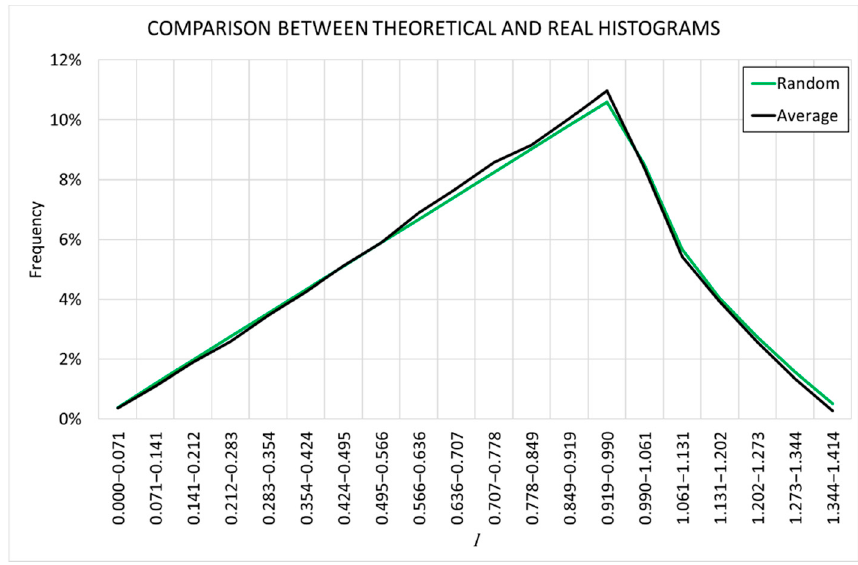
Figure 9. Circumferential test. Comparison between real and theoretical histograms.